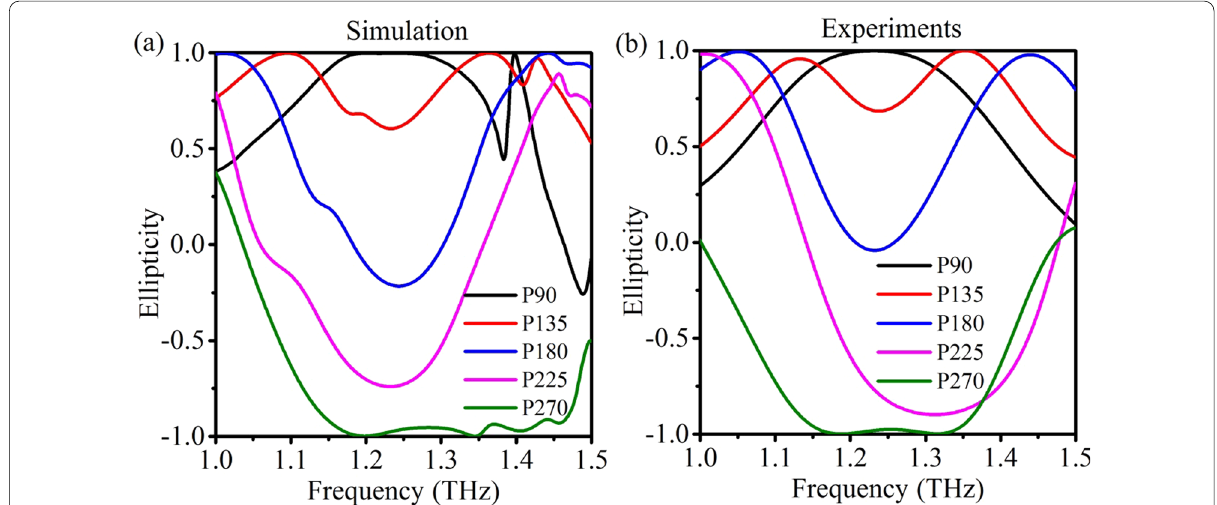
Fig. 3 a Simulated and b experimental measured ellipticity of different dielectric